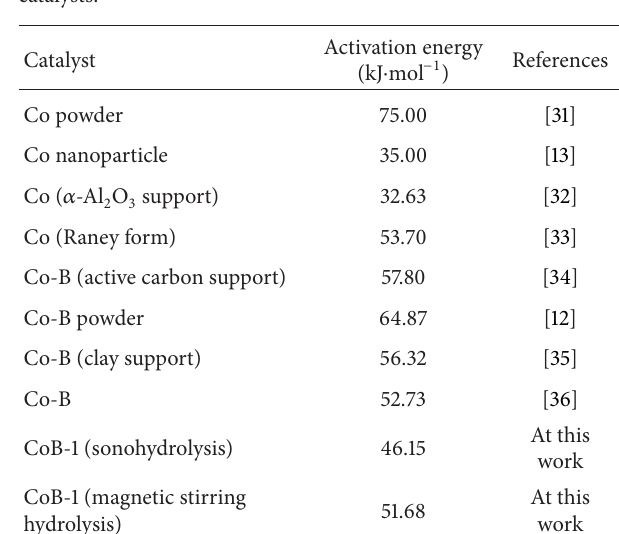
Table 3: Activation energies in presence of various Co-based